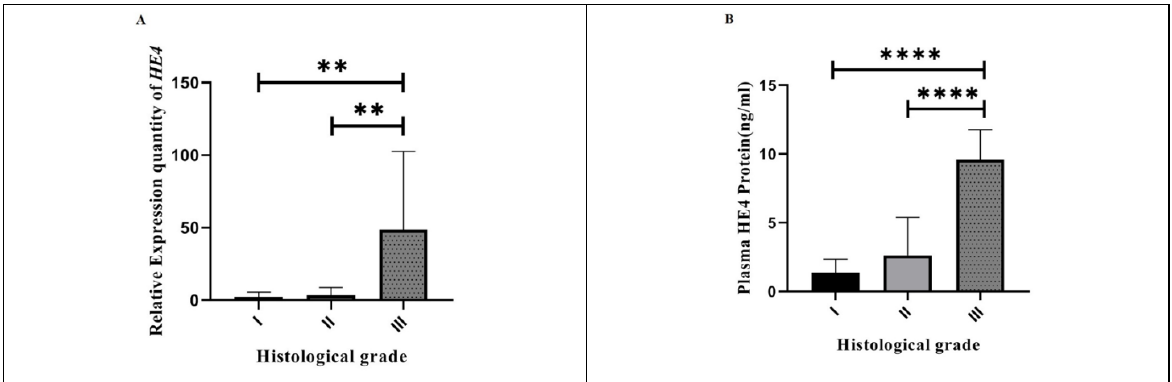
Fig. 2. Correlation between HE4 expression and tumor grade. A: The relative expression of HE4 in three grades of breast cancer (Grade I (n = 6), Grade II (n=15), Grade III (n = 9)). As shown, HE4 mRNA expression in grade III was significantly higher compared with grade I ( P <0.001 for both). B: Correlation between plasma HE4 expression and histological grade. As shown, plasma HE4 expression in grade III (n=13) was significantly higher compared with grade I (n=10) and grade II (n=19) ( P <0.0001 for both).